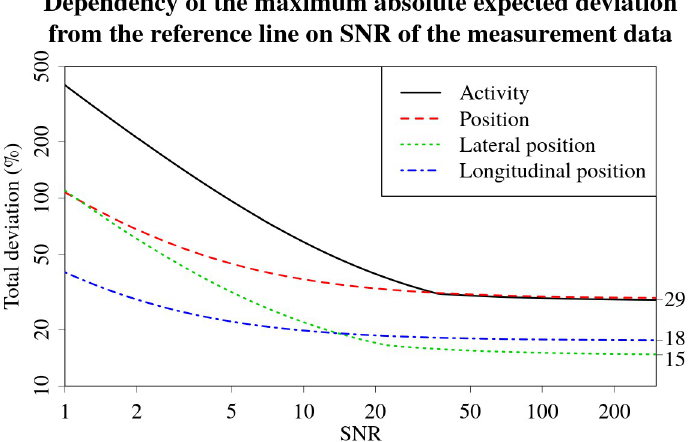
Fig 18. Graphs of maximum absolute expected deviation from the reference line (between 5%, 95% and 50% quantiles for activity—solid black, lateral position—dotted green, longitudinal position—dot-dashed blue, and between the x axis and the 90% quantile for combined position deviations—dashed red). Asymptote values for the curves are displayed on the right axis of the